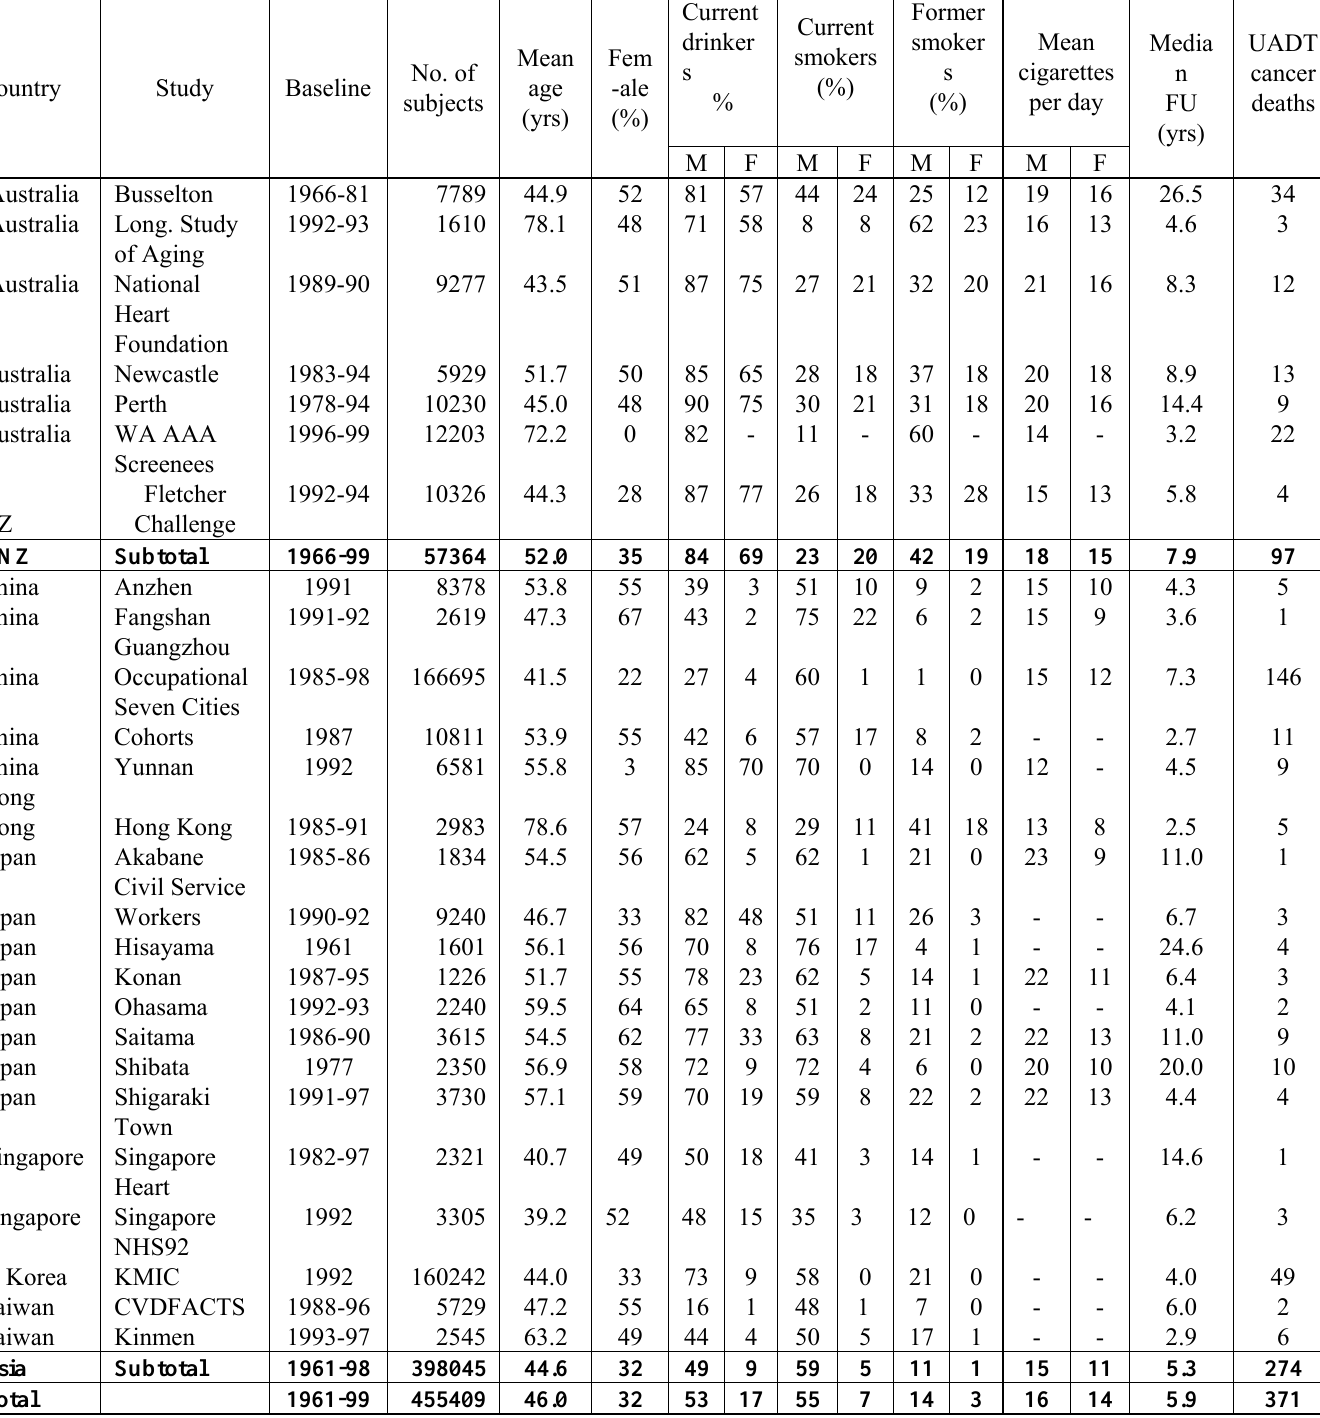
Table 1. Characteristics at baseline and details of follow-up, for all studies, by